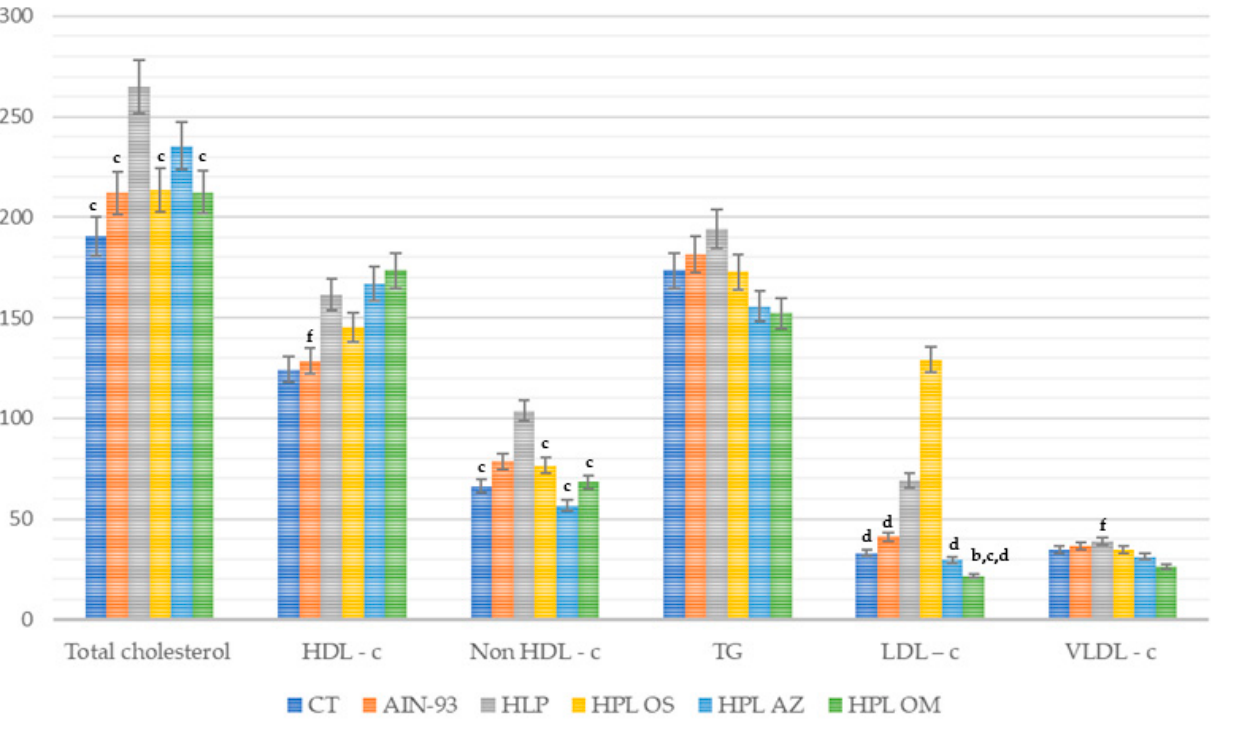
Figure 4. Total cholesterol, fractions, and triglycerides (mg/dL) of animals fed a balanced or high-fat diet and supplemented with saline, soybean oil, olive oil, or seed oil of papaya ( Carica papaya Linn). Values expressed as mean ± standard deviation. Letters indicate statistical difference as follows: b compared to AIN 93; c compared to HPL; d compared to HPL OS; f compared to HPL OM. p < 0.01. n = 14–18. ANOVA followed by Tukey post test.